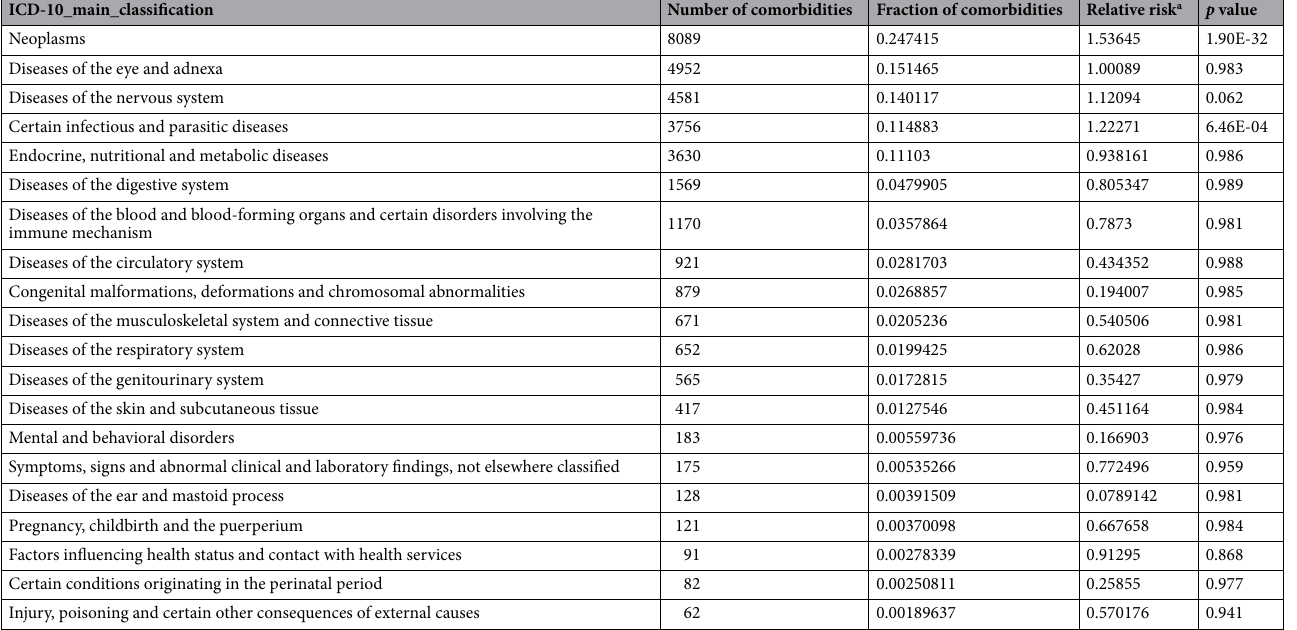
Table 1. Comorbidities of 20 ICD-10 main classifications for viruses. a See text for definition.